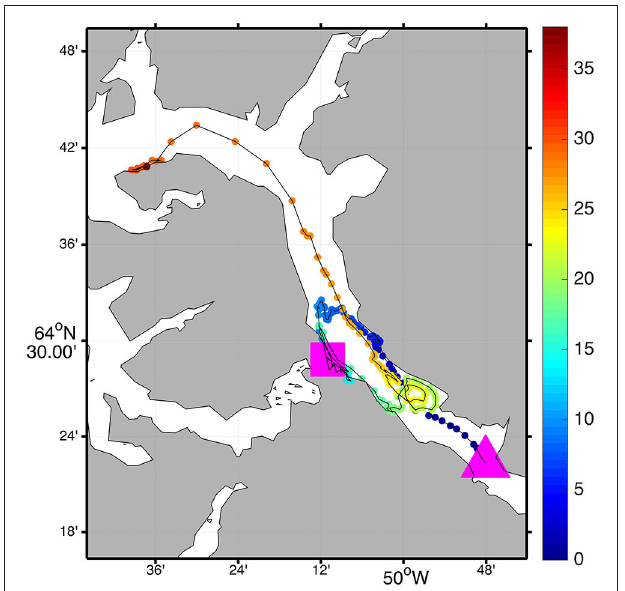
FIGURE 5 | A trajectory of an EXITE beacon initially deployed at the large pink triangle. Locations are color-coded according to time, in days, since deployment. Every 4th measurement is shown for clarity. The location where the critical acceleration was exceeded is indicated by the large pink square.